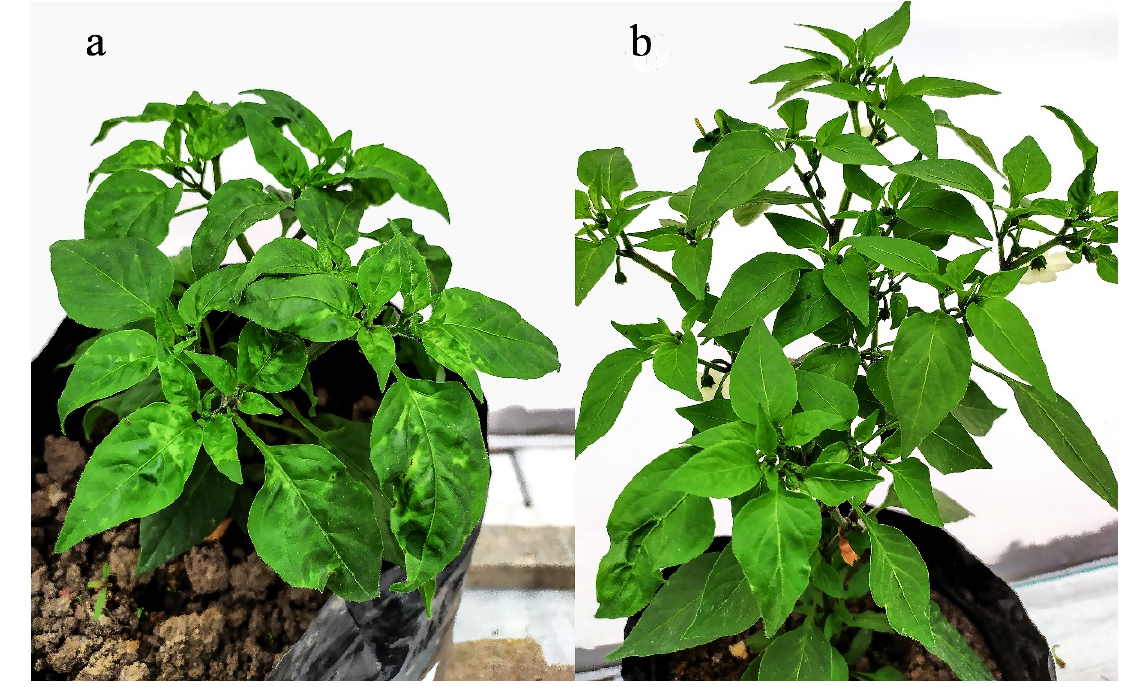
Figure 4. ( a ) TMV-infected plants. ( b ) TMV-infected plants treated with TiO 2 NPs 150 μ g/mL.